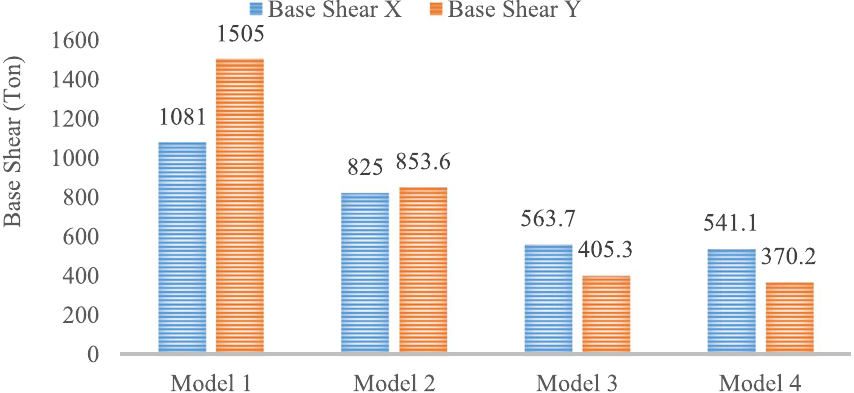
Fig. 22 The results of base shear of the bridge in longitudinal (X) and transversal (Y) directions under the influence of the Tabas